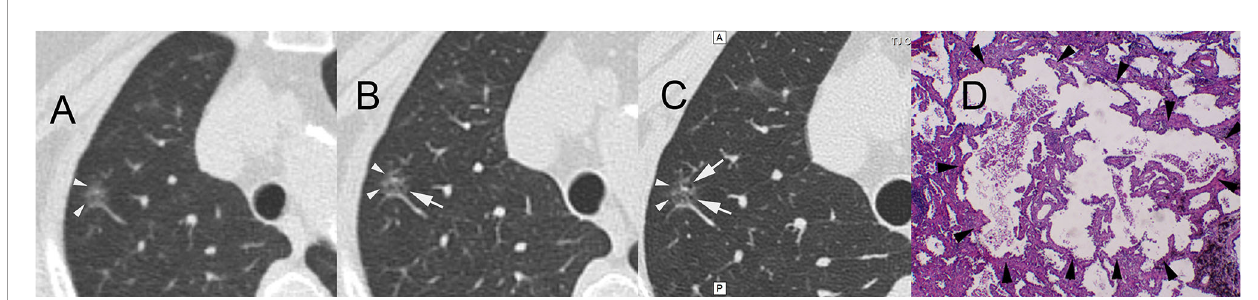
FIGURE 4 | A 61-year-old female patient with ground-glass nodules in the posterior segment of the right upper lobe detected by LDCT screening. AI indicated that the malignant rate was 60.65%. Surgical resection revealed invasive mural adenocarcinoma. CT images reconstructed by lung window. (A) LDCT image. The white arrowheads indicate GGNs. (B) Conventional CT image. The white arrow indicates small bubble-like lucencies with unclear boundaries. (C) HRCT local-target scanning image. The white arrows indicate several bubble-like lucencies with clear boundaries. (D) Pathological HE staining image (×40) showing the destruction and fusion of two bubble-like lucencies (arrowheads) in the middle of the background of invasion and growth of tumour tissue. AI, arti fi cial intelligence; LDCT, low-dose computed tomography; GGN, ground-glass nodule; HRCT, high-resolution computed tomography.